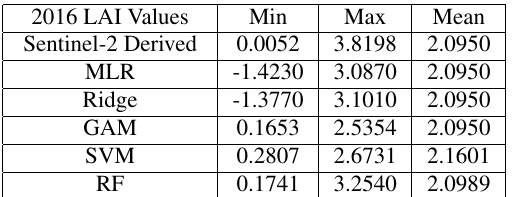
Table 1. Derived and predicted LAI values for each model in 2016.